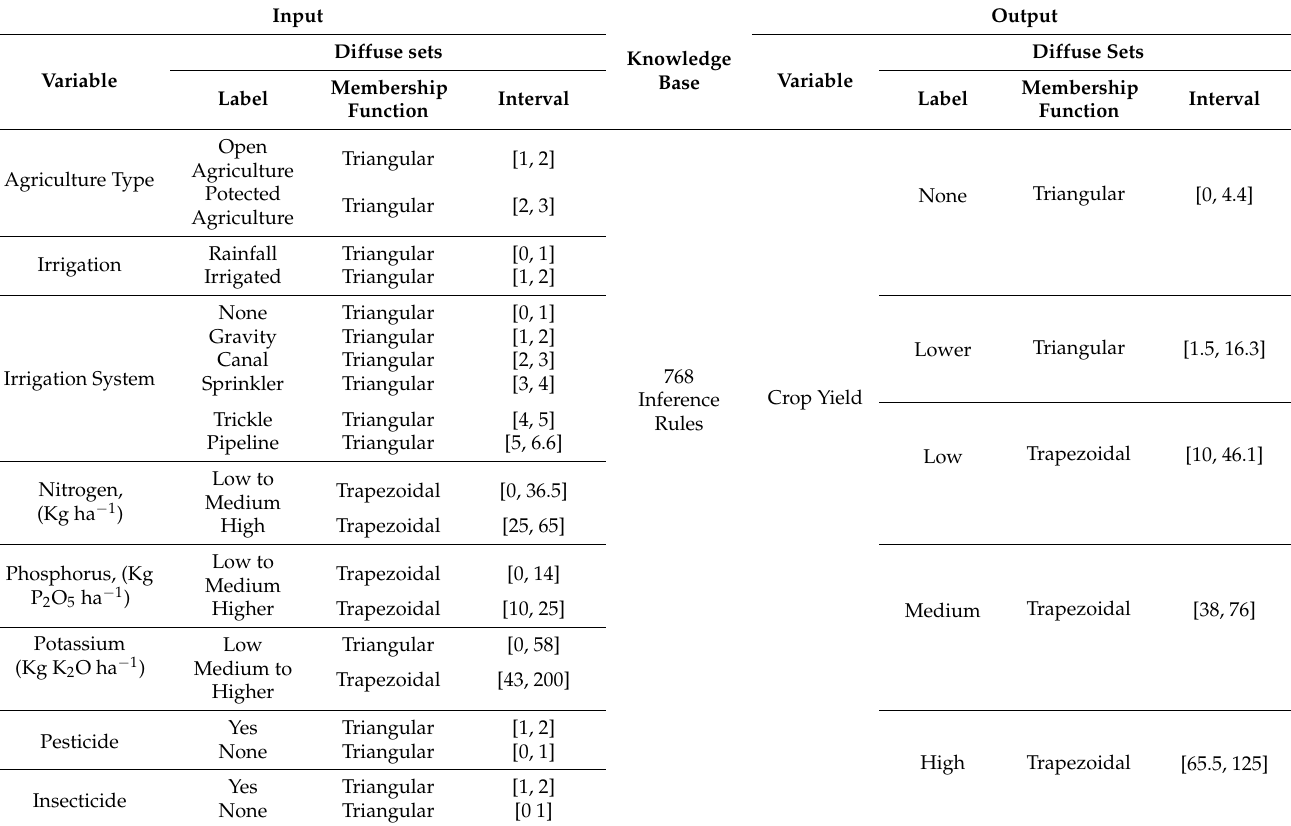
Table A1. Crop yiel model: fuzzy sets and operation intervals.